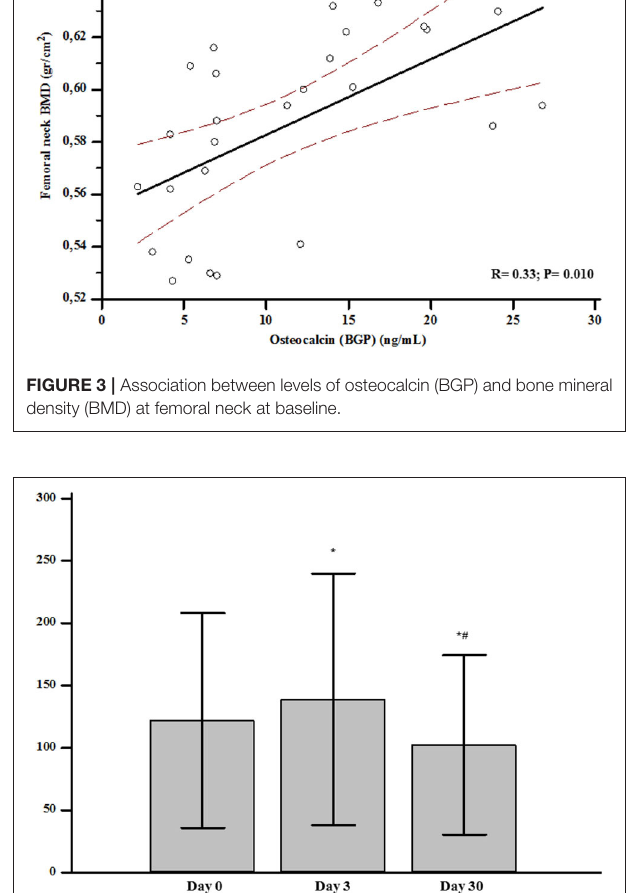
( Figure 1 ), and this correlation was maintained even after adjusting for age and BMI ( r = 0.58; p = 0.01).